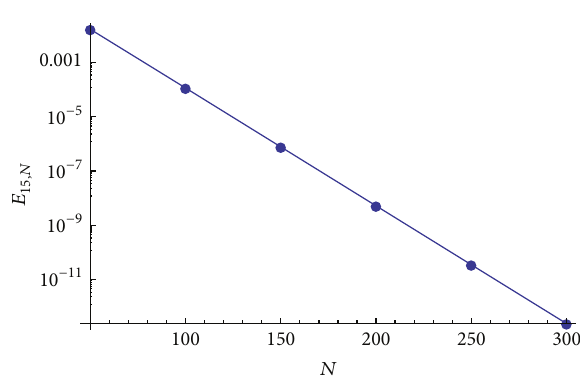
Figure 4: Maximum error related to different quadrature points in Example